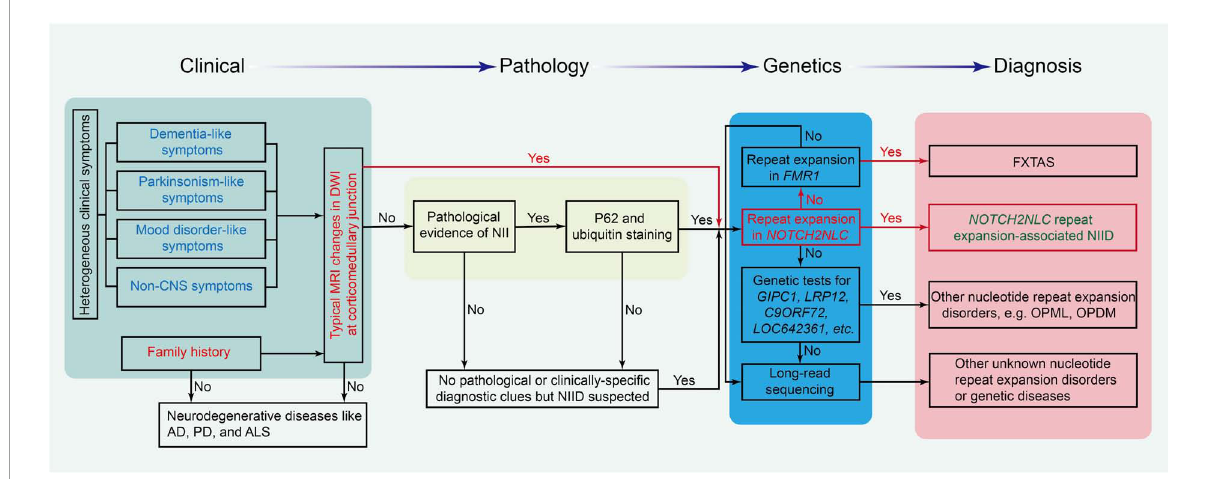
FIGURE4 The flowchart for the diagnosis of NIID and its differential diseases. Different background colors in the chart show the four critical parts of the diagnosis protocol. AD, Alzheimer’s disease; ALS, amyotrophic lateral sclerosis; FXTAS, fragile X-associated tremor/ataxia syndrome; NII, neuronal intranuclear inclusion; PD, Parkinson’s